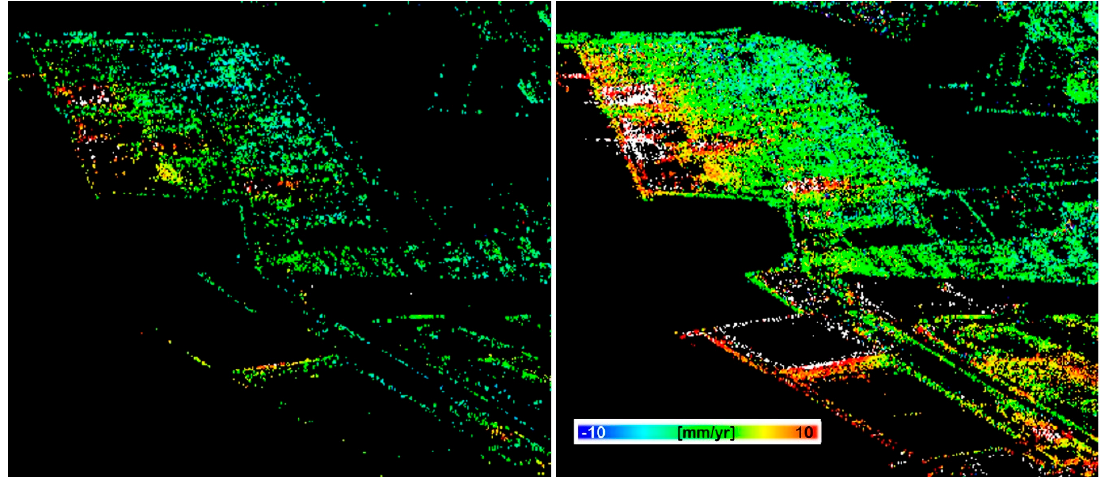
Figure 2. Deformation velocity obtained by PSI ( Left ) and by TomoSAR ( Right ).